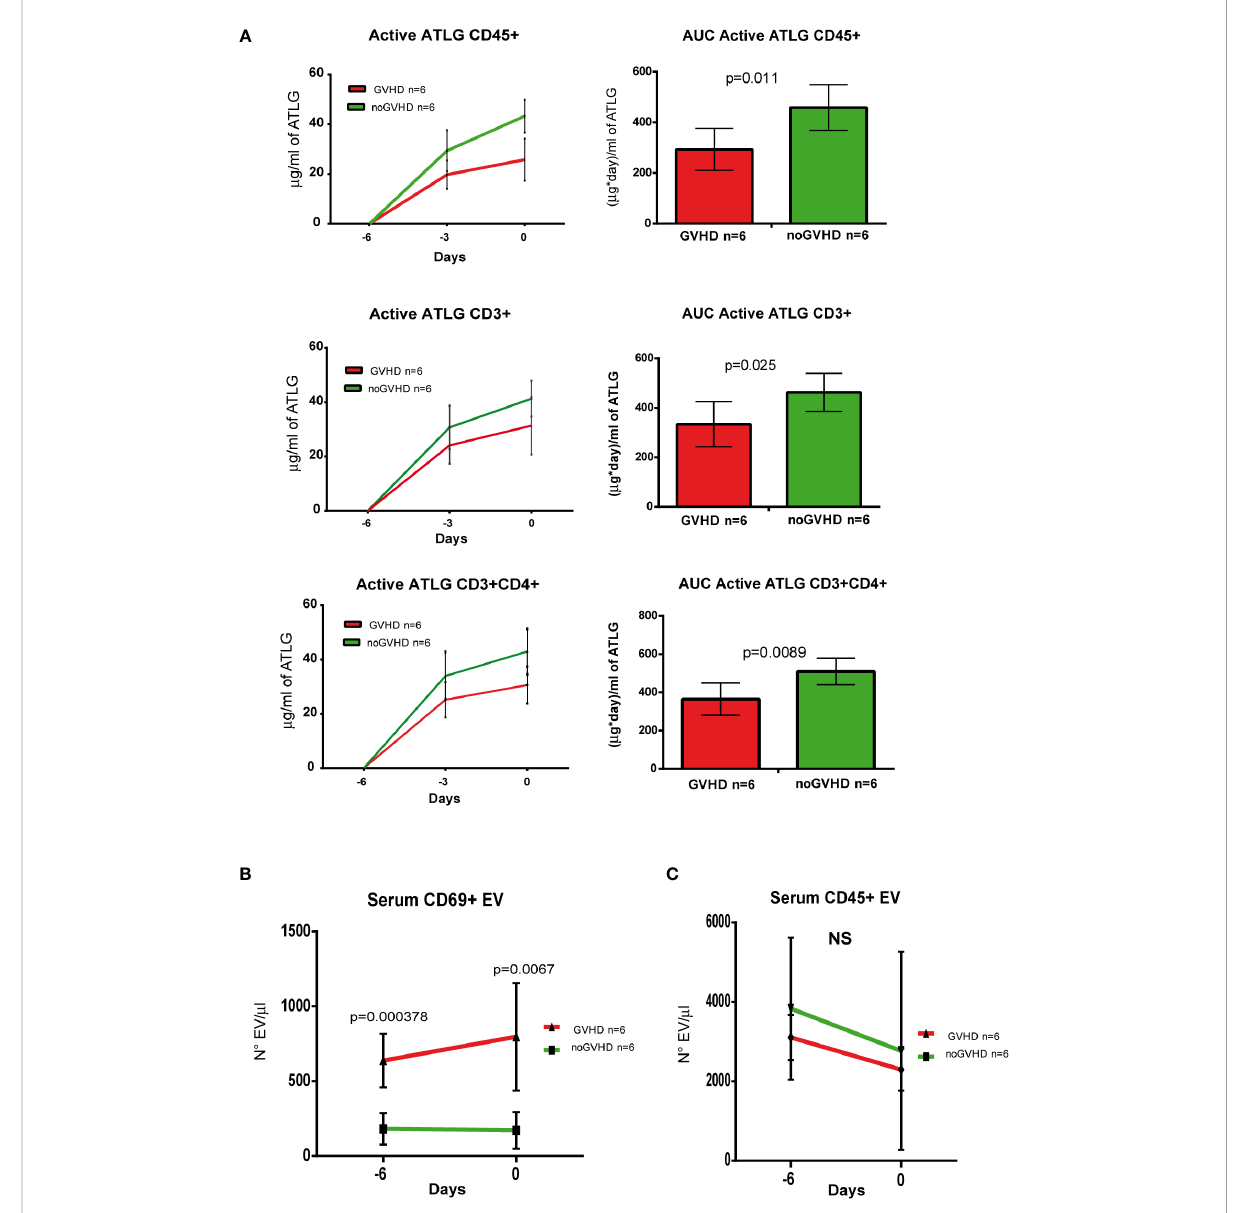
FIGURE 6 Validation of ATLG kinetics and CD69+ EVs as markers of GVHD onset. (A) , Pharmacokinetic analysis (left panel) and AUC (right panel) at day -6, day -3, and day 0 of active ATLG bound to: CD45+cells, CD3+ and CD3+/CD4+ lymphocytes; (B) FACS analysis of day -6 and day 0 serum CD69+ EVs in GVHD (n = 6) and noGVHD (n = 6) patients. (C) FACS analysis of day -6 and day 0 serum CD45+ EVs in GVHD (n = 6) and noGVHD (n = 6) patients. NS, Not Signi fi